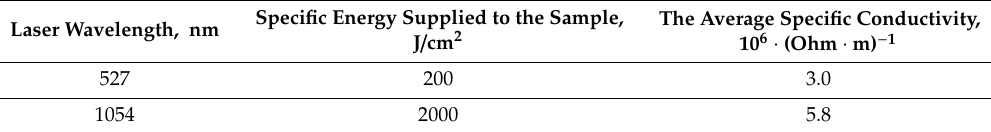
Table 3. The average specific conductivity of lines sintered by pulsed laser radiation on polyamide